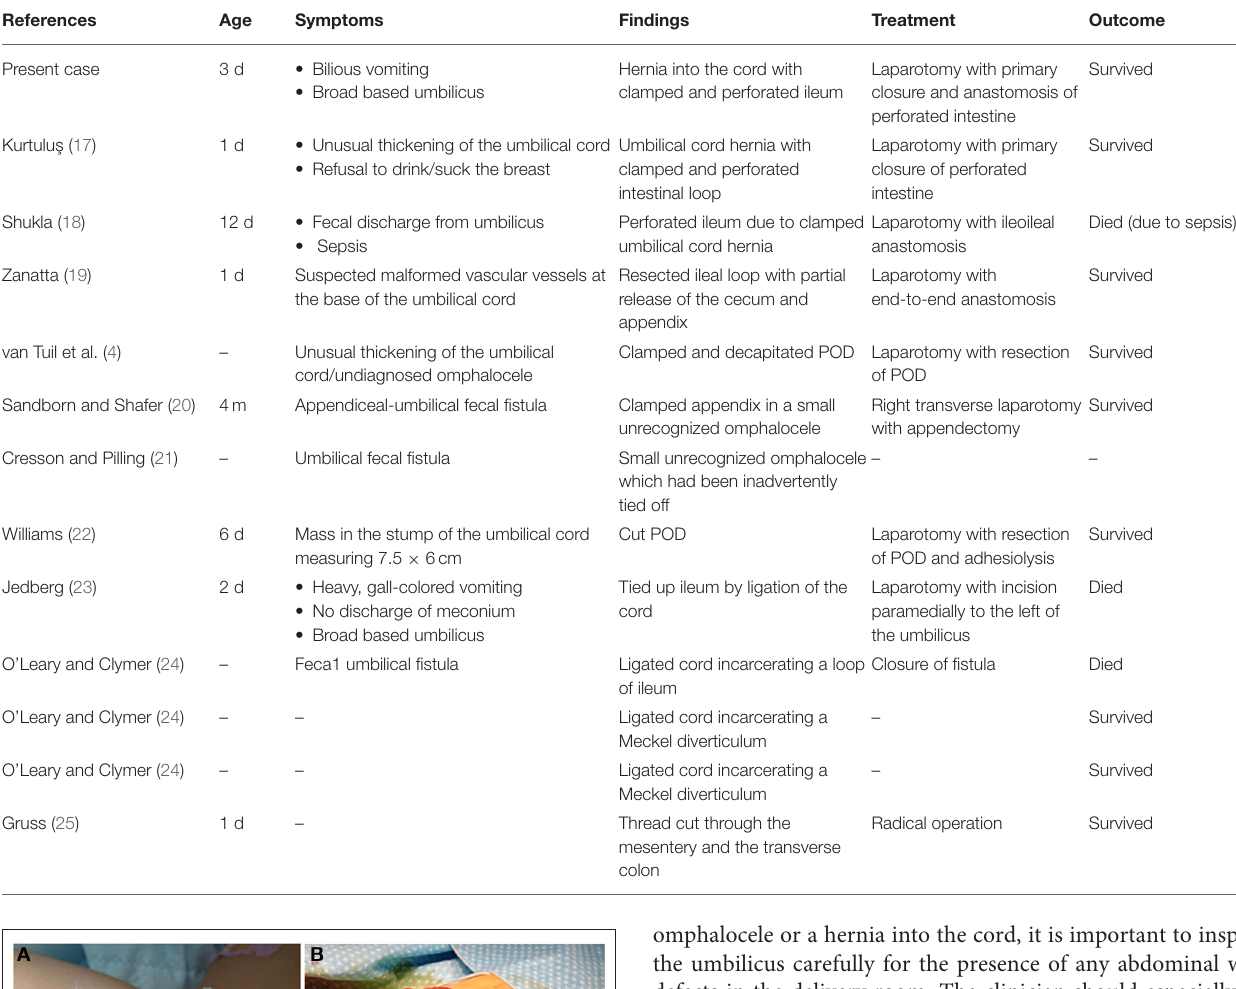
TABLE 2 | Cases of literature search (d, days; m, months; POD, persistent omphaloenteric